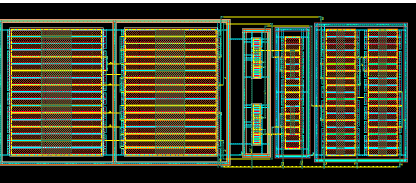
Figure 15. Layout of the CMOS OTA providing gm = 500 µ A/V.